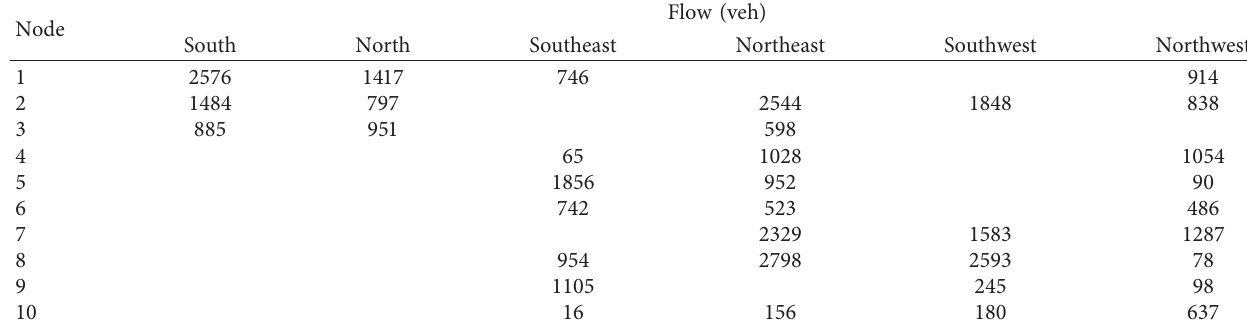
Table 1: Experimental traffic network node import flow.